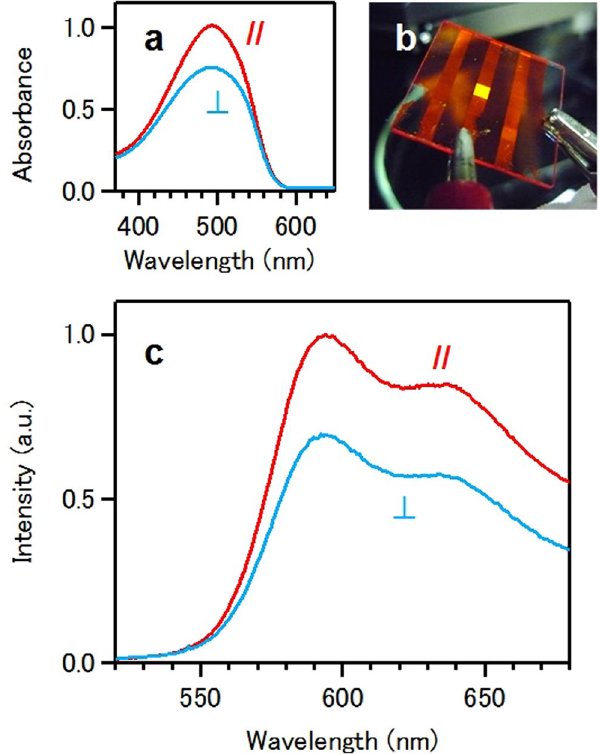
Figure 7. Polarized light-emitting device as an application using the soft friction transfer method. ( a ) Polarized absorption spectra of MEH-PPV film prepared by the soft friction transfer method. Red and blue spectra represent the spectra obtained using incident light polarized parallel (//) and perpendicular ( ⊥ ) to the brushing direction, respectively. ( b ) Photograph of the device composed of Al/MEH-PPV/ITO/glass-substrate. ( c ) Polarized EL spectra of the device. Red and blue spectra represent the spectra of light polarized parallel (//) and perpendicular ( ⊥ ) to the brushing direction,